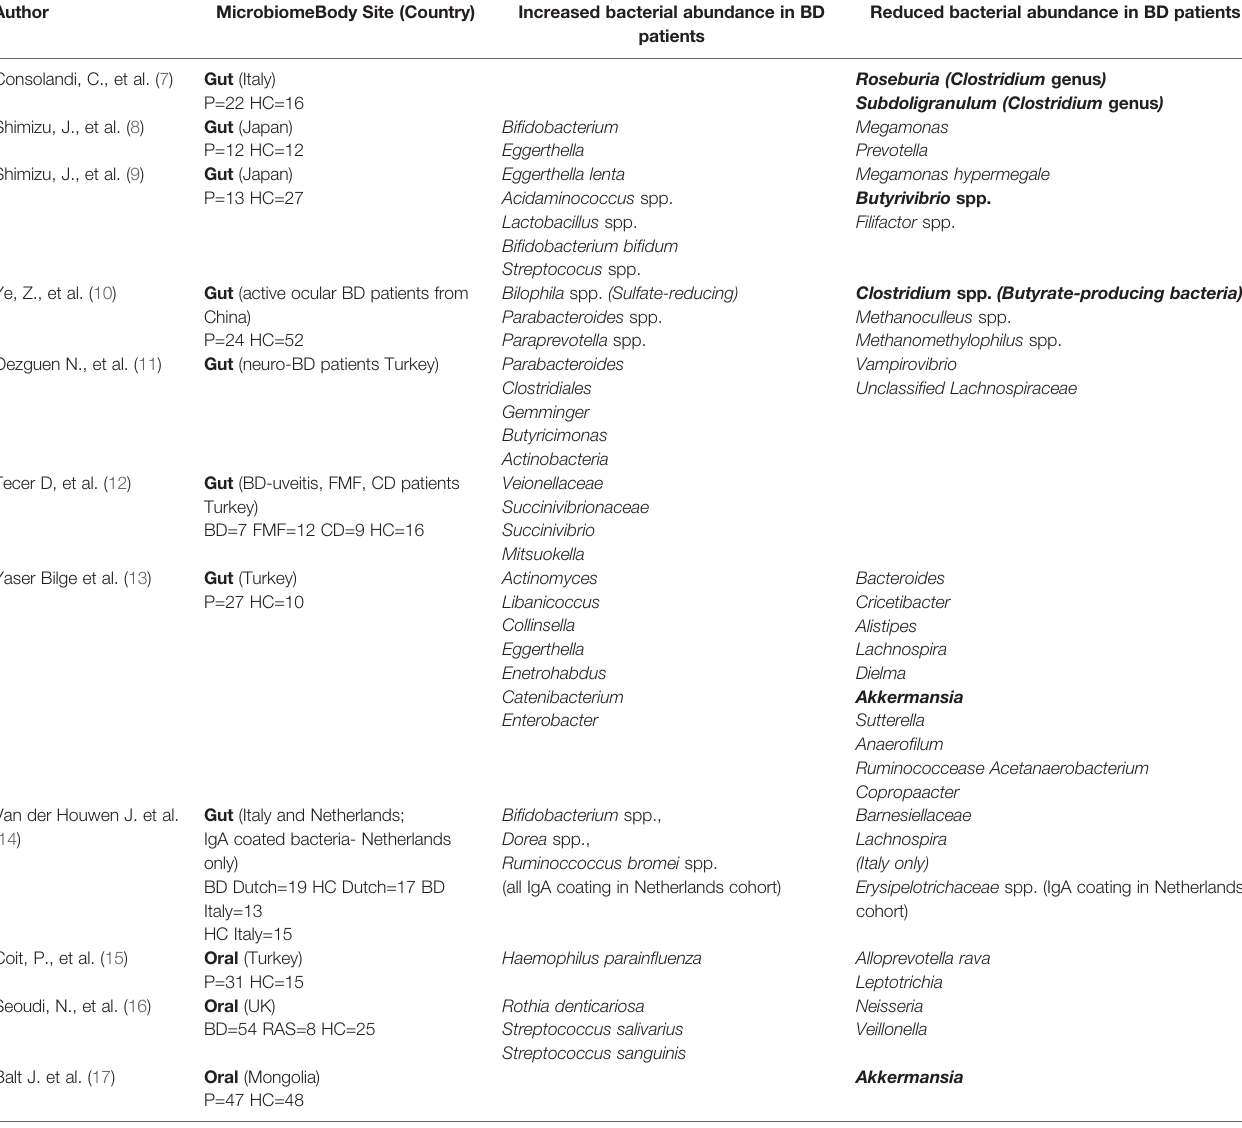
TABLE 1 | Summary of microbiome dysbiosis in Behc ̧ et ’ s Disease patients compared to healthy controls or disease